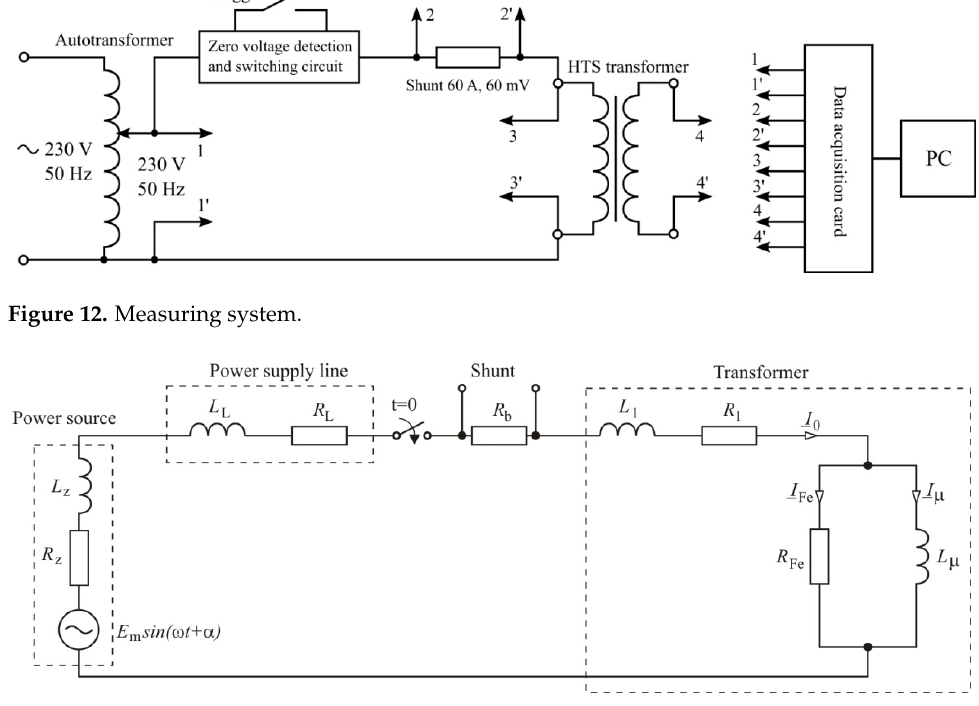
Figure 13. Electrical circuit diagram.